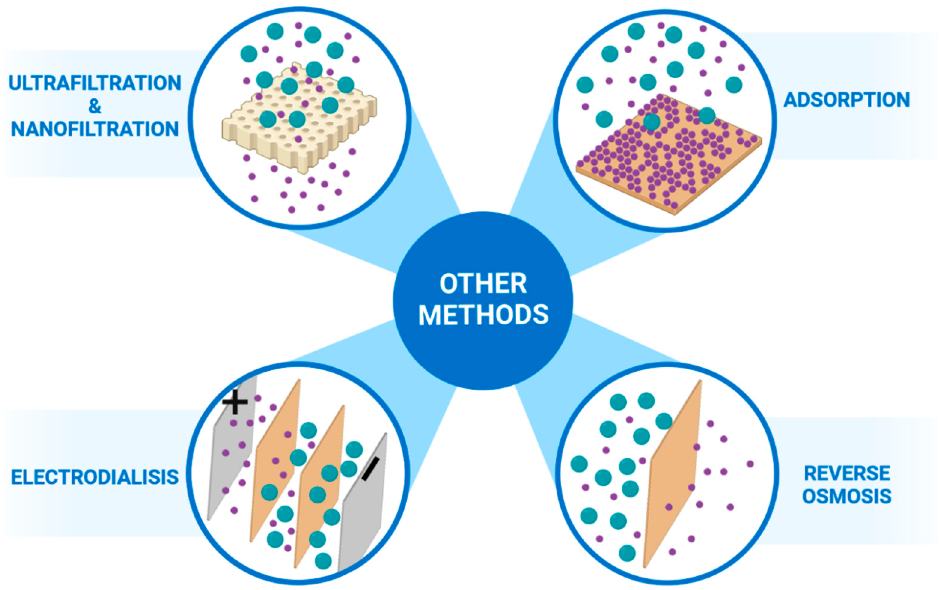
Figure 2. The application of magnetic membranes in other separation methods: ultrafiltration & nanofiltration, for water desalination, adsorptio of cations from water, electrodialysis, reverse osmosis groundwater purification. Created with BioRender.com.